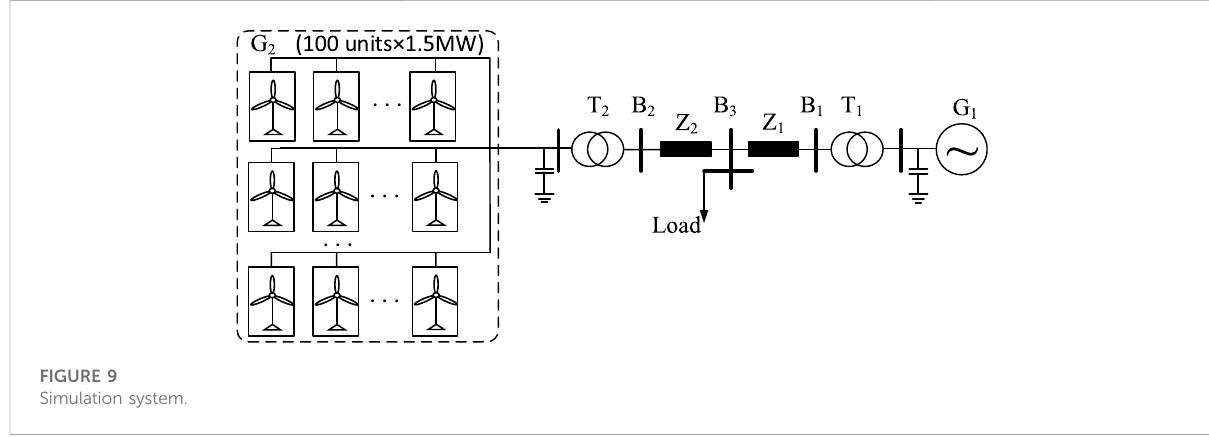
FIGURE 9 Simulation system.